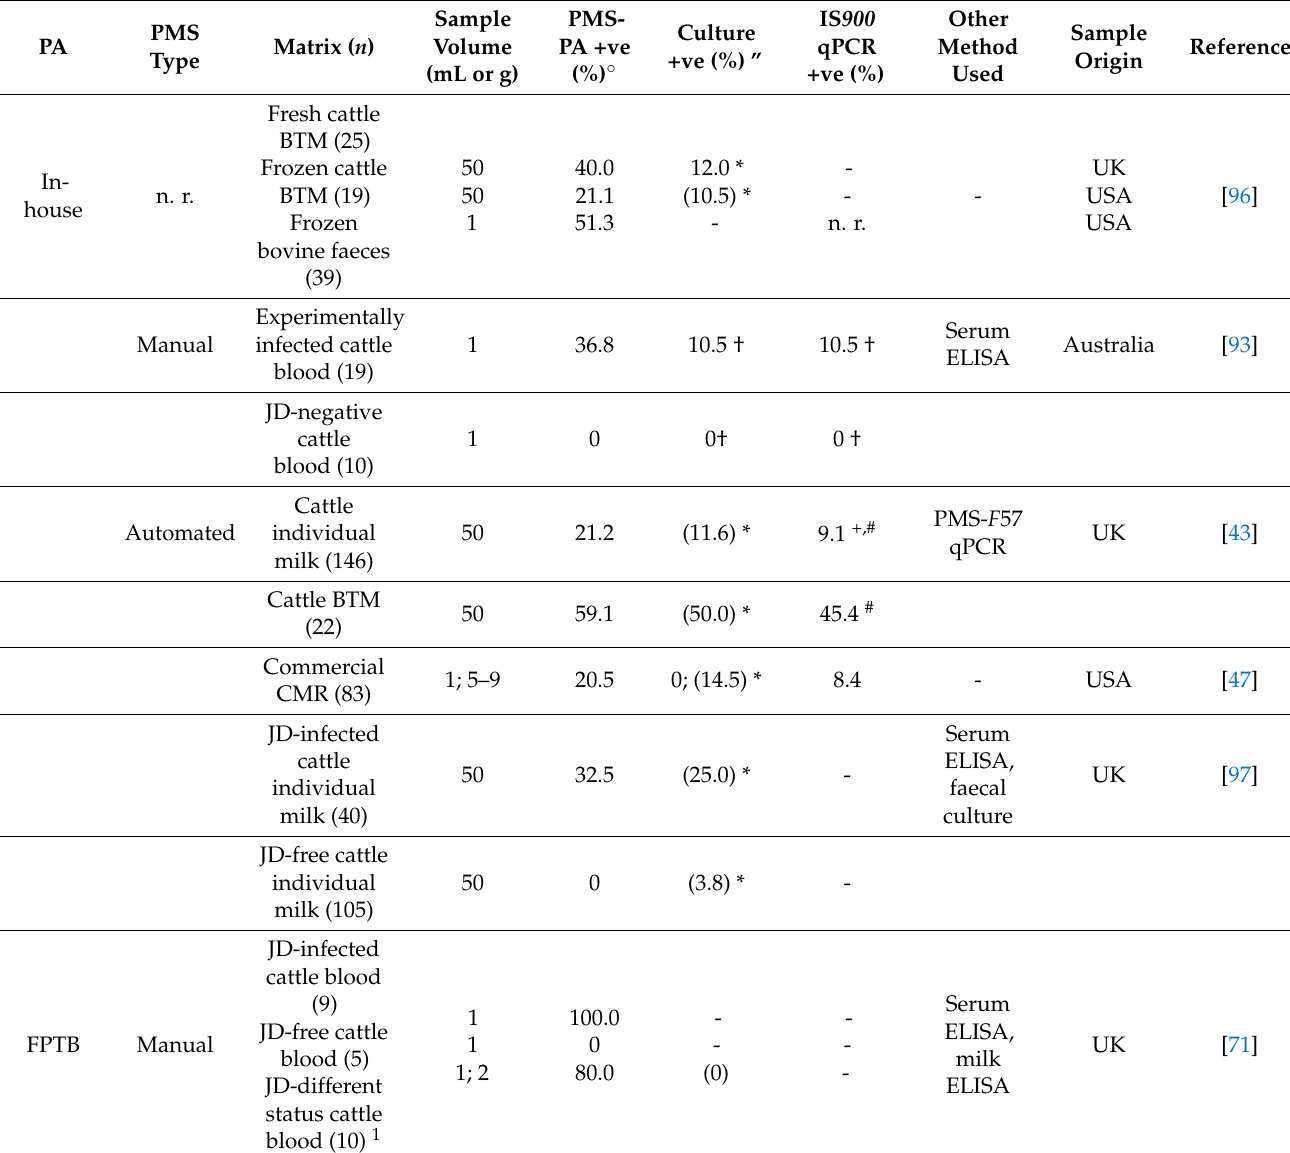
Table 6. Detection of M. avium subsp. paratuberculosis in real samples by a combination of methods: peptide-mediated magnetic separation and phage amplification